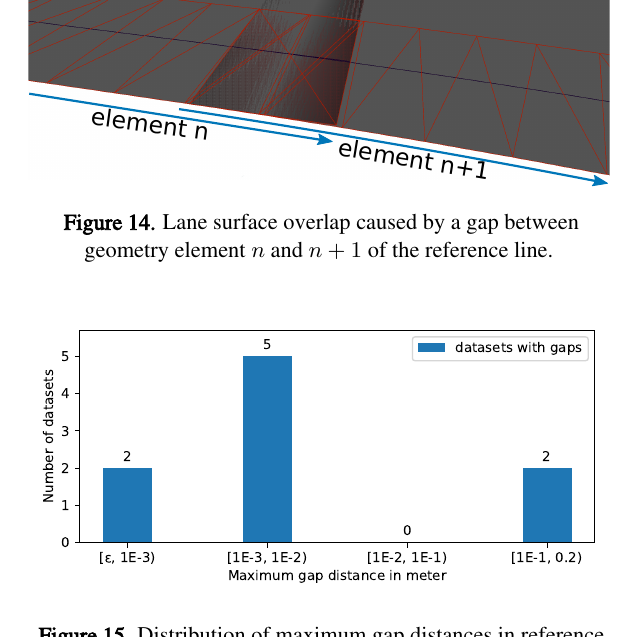
Figure 15. Distribution of maximum gap distances in reference line per